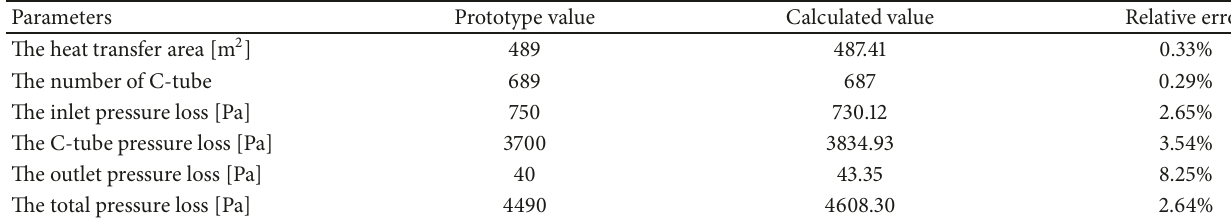
Table 3: The comparison original design and calculating results.